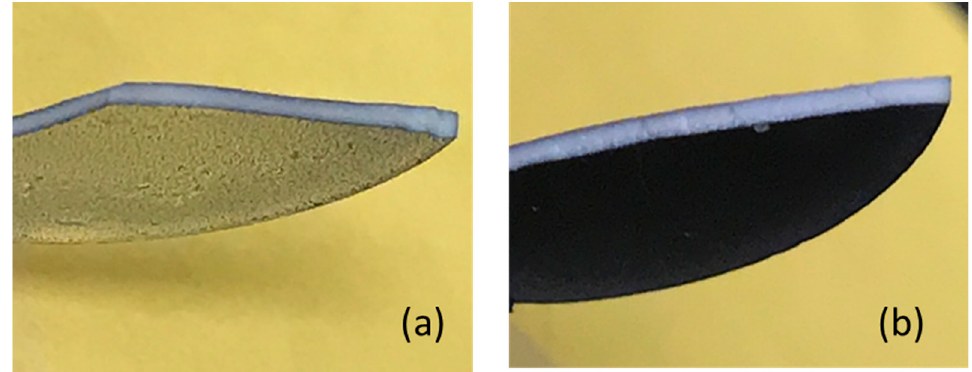
Figure 10. ( a ) A fractured piece of the sample showing metallic surface and grey interior. ( b ) The fractured sample after leaching in HNO 3 . The surface has turned dark in color. fractured sample after leaching in HNO 3 . The surface has turned dark in